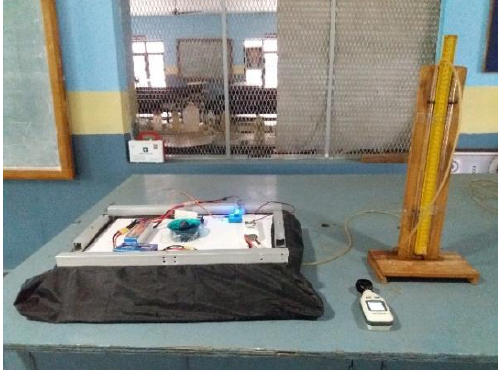
Figure 12. Manometer is connected with hovercraft Figure 13. Measurement of air intake velocity